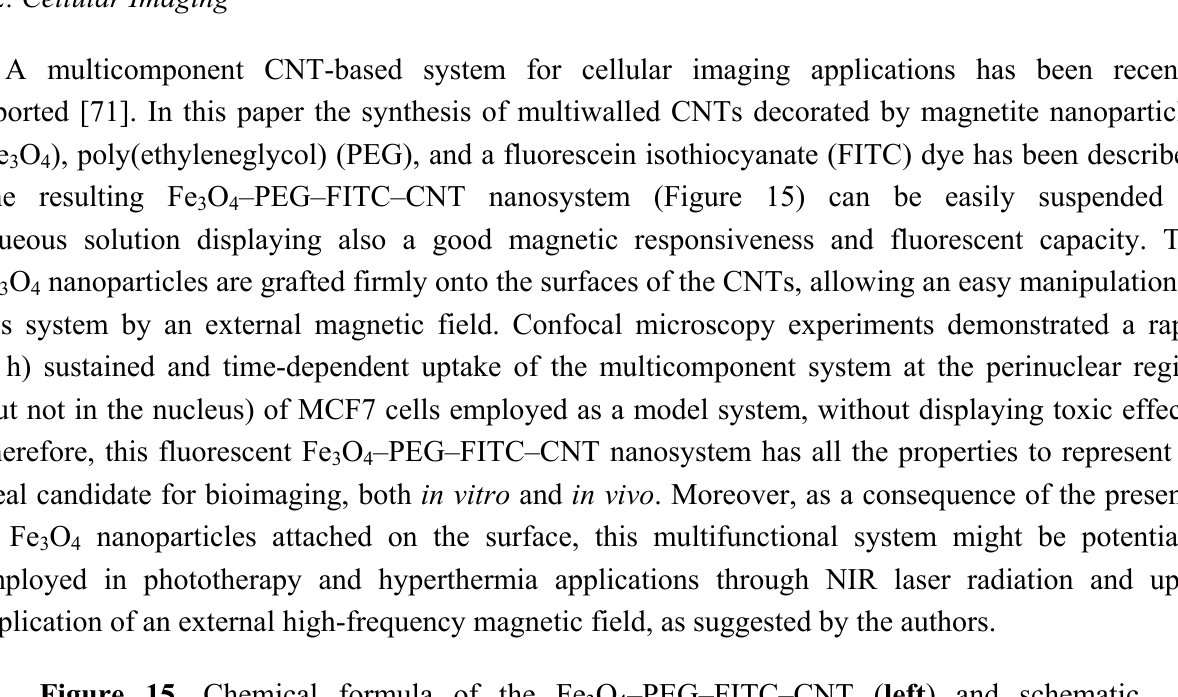
O –PEG–FITC–CNT ( left ) and schematic 3 4 O -PEG-FITC-CNT nanoparticles bound to glutathione 3 4